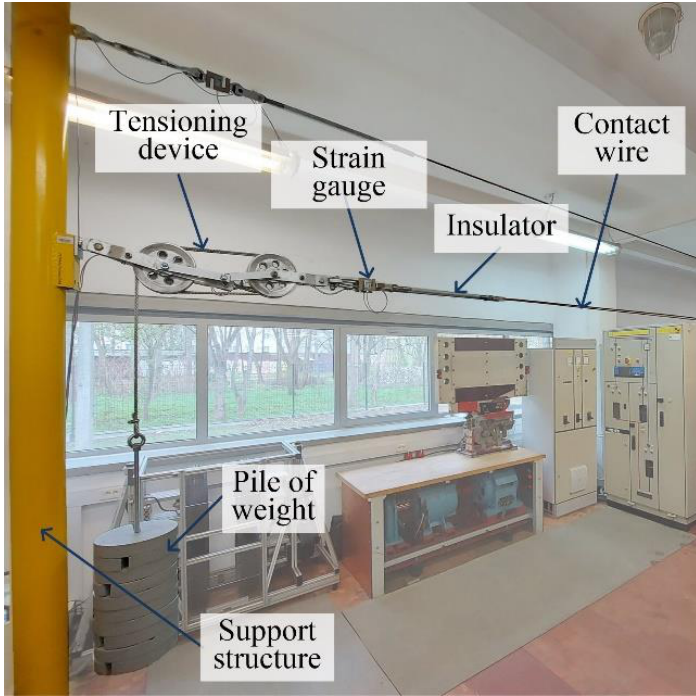
Figure 10. Tensioning construction – strain gauge for force measurement seen in the center.